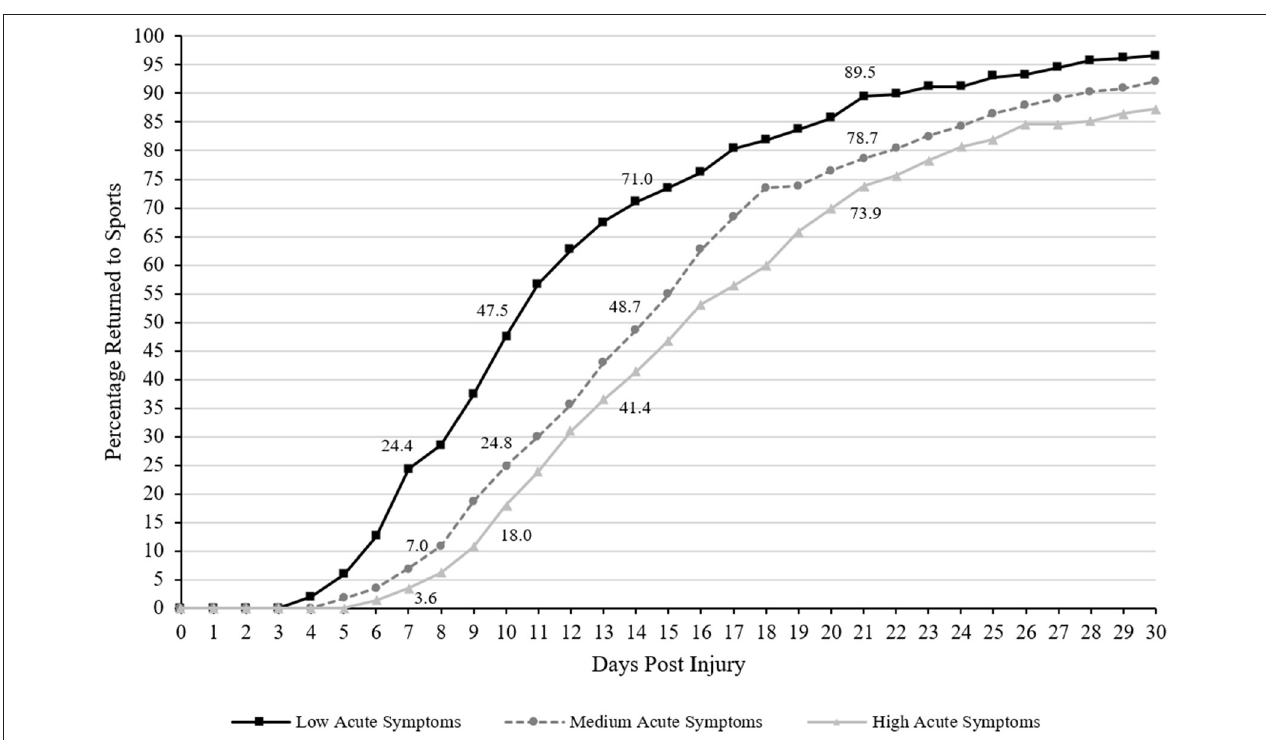
FIGURE 2 | Days to Return to Sports (cumulative percentage curves). Cumulative percentage curves by group of time to return to sports. The featured percentages are as follows: 7 days (3.6% of those with high acute symptom severity, 7% of those with medium acute symptom severity, 24.4% of those with low acute symptom severity), 10 days (18% of those with high acute symptom severity, 24.8% of those with medium acute symptom severity, 47.5% of those with low acute symptom severity), 14 days (41.4% of those with high acute symptom severity, 48.7% of those with medium acute symptom severity, 71% of those with low acute symptom severity), and 21 days post injury (73.9% of those with high acute symptom severity, 78.7% of those with medium acute symptom severity, 89.5% of those with low acute symptom